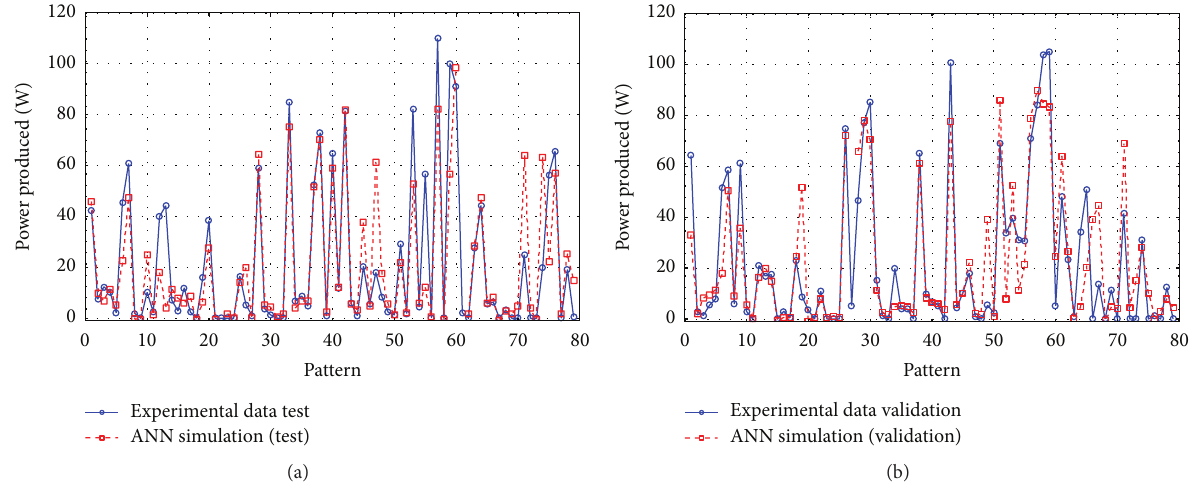
Figure 15: Power produced from experimental results and from prediction ANN analysis on data test (a) and data validation